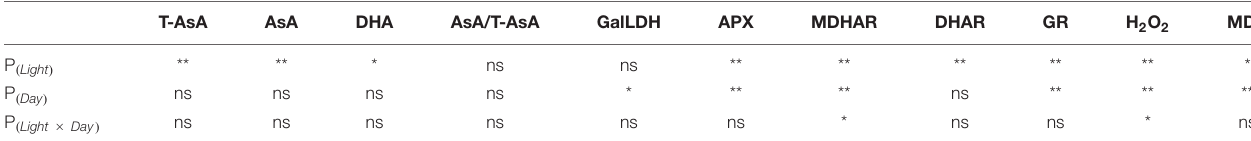
The samples were taken on the 12th day after treatment. Values are the means of five replicates. Different letters indicate significant differences between different treatments at p < 0.05 according to the Tukey test. TABLE 3 | P -values of the two-way ANOVA for the effects of light treatments (Light) and days of light treatments (Day) on the physiological parameters.